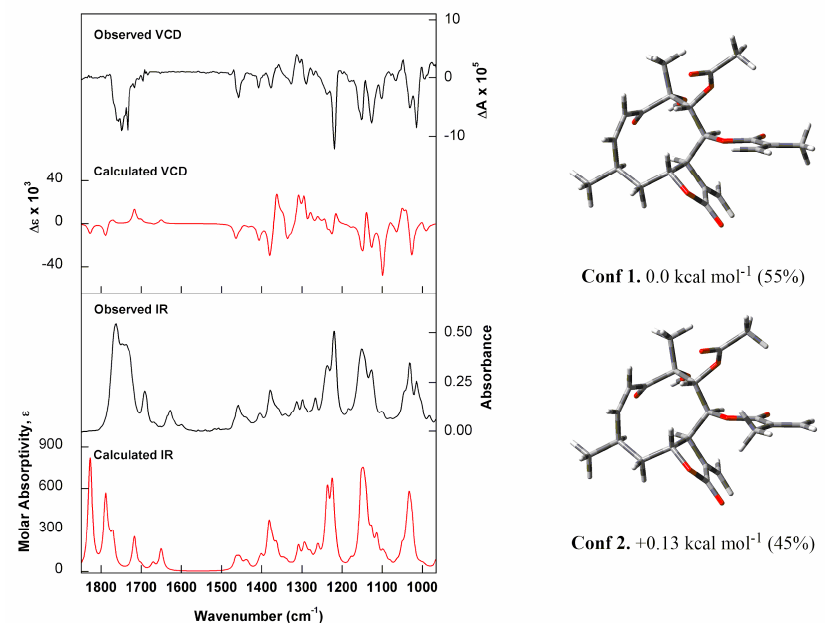
Figure 3. (Left) Comparison of experimental IR and vibrational circular dichroism (VCD) spectra of ( − )- 1 recorded in CDCl 3 (black trace) with the calculated [B3PW91 / 6-311G(d,p)] IR and VCD spectra for the Boltzmann average of the two lowest-energy conformers identified for (4 R ,6 R ,7 S ,8 S ,9 R ,10 R )- 1 (red trace). (Right) Optimised structures, relative energies and Boltzmann populations of the lowest-energy conformers identified for (4 R ,6 R ,7 S ,8 S ,9 R ,10 R )- 1 .